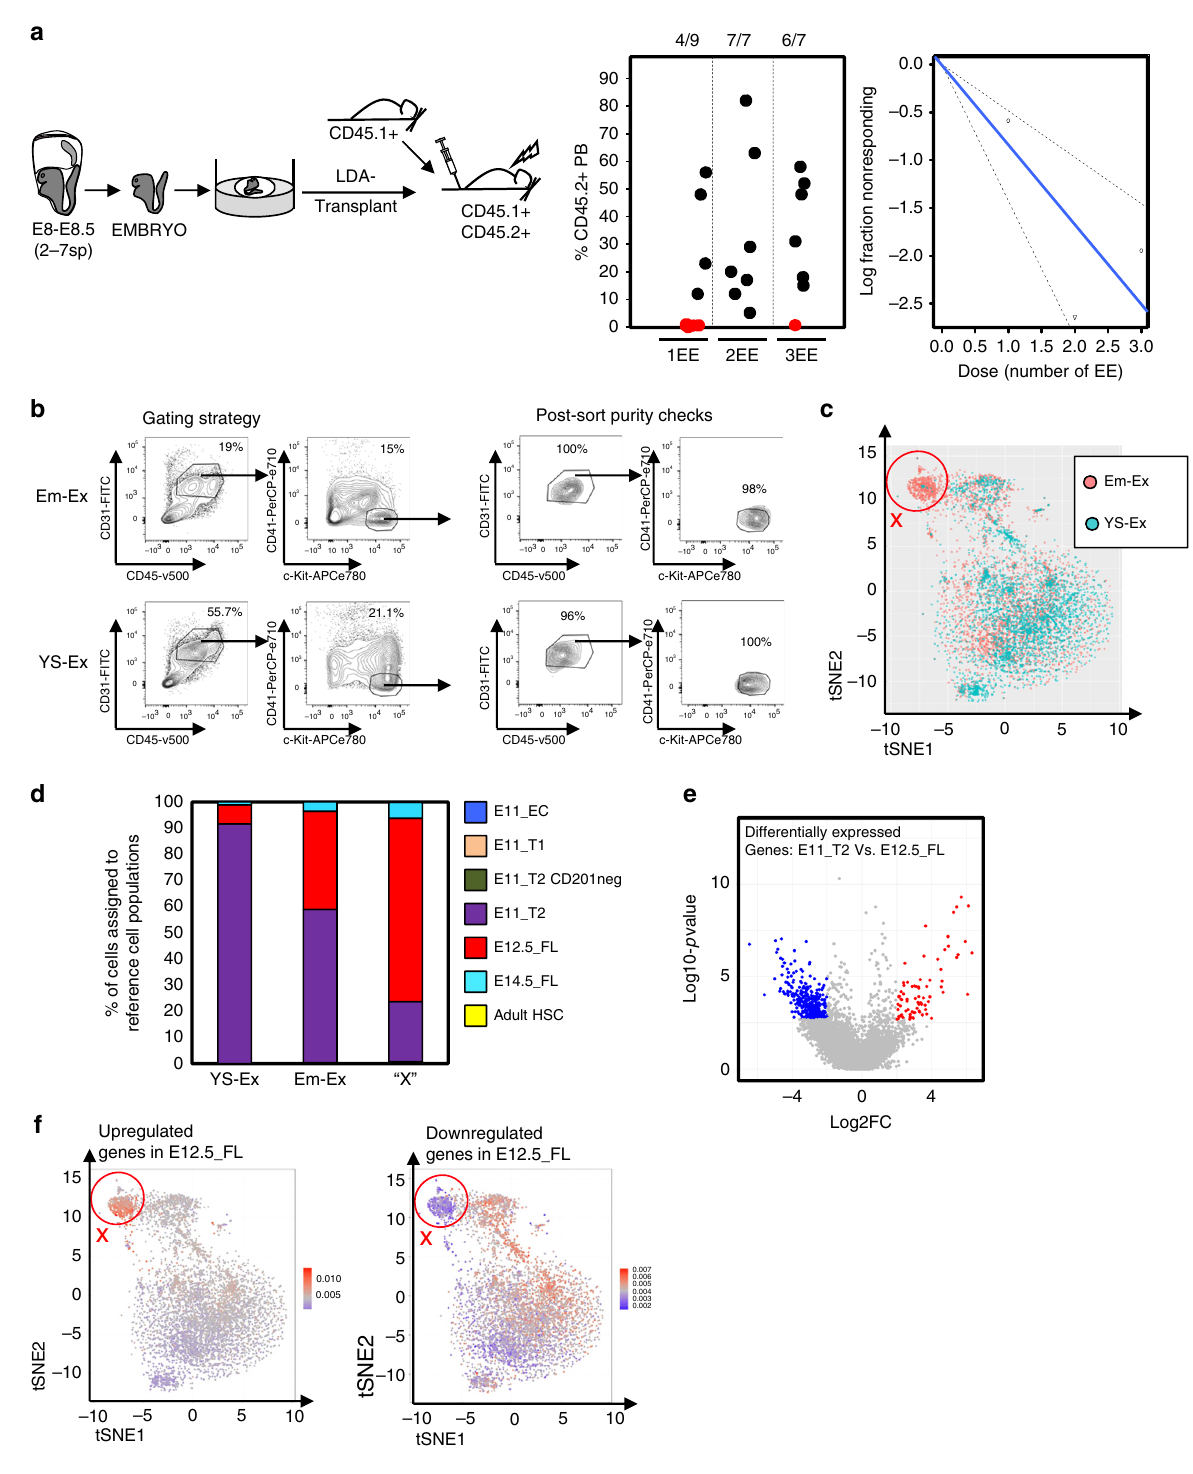
immaturity relative to Em-Ex cells (Fig. 4d). A comparison of E11.0-T2-pre-HSC and E12.5-FL HSC revealed 353 down- regulated genes and 80 upregulated genes (FDR<0.05 and Log